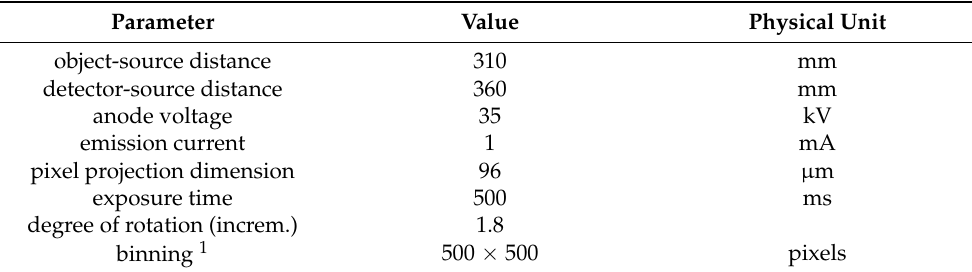
Table A1. Values of set parameters on the PHYWE XR 4.0 assembly.